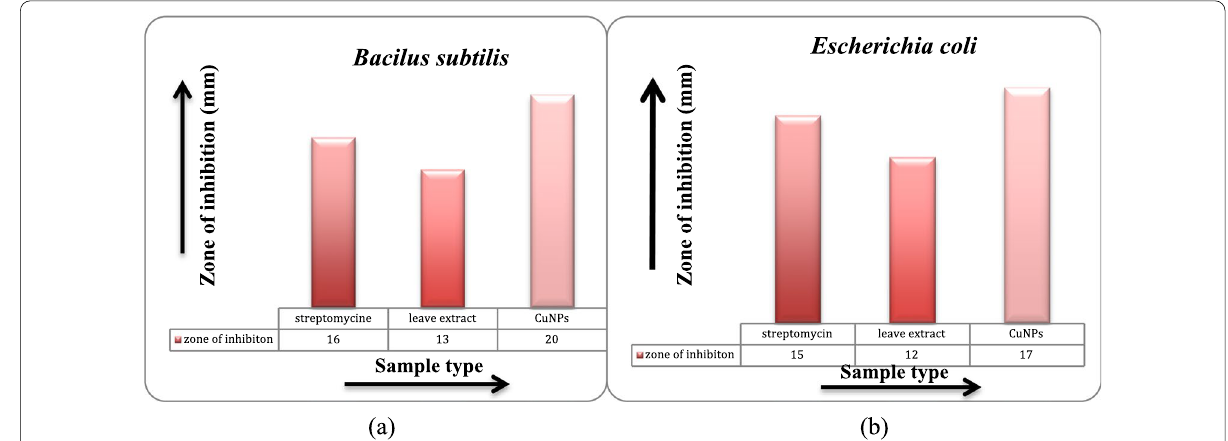
Fig. 5 Anti‑Bacterial activity of Grewia asiatica leave extract and copper nanoparticles against Bacillus subtilis and Escherichia coli